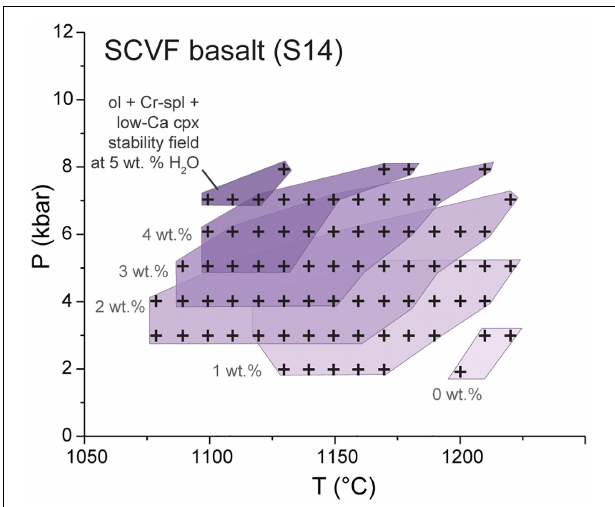
FIGURE 11 | Results of MELTS equilibrations of SCVF basalt S14 (Straub et al., 2015) over a range of 1080–1220 ◦ C (10 ◦ C steps), 1–12 kbar (1 kbar steps) and 0–6 wt.% H 2 O (1 wt.% steps) at fO 2 = FMQ -0.2 (Straub and Martín-Del Pozzo, 2001). Crosses and shaded areas outline P-T stability fields of olivine + Cr-spinel + low-Ca clinopyroxene at varying H 2 O-concentrations. See text for